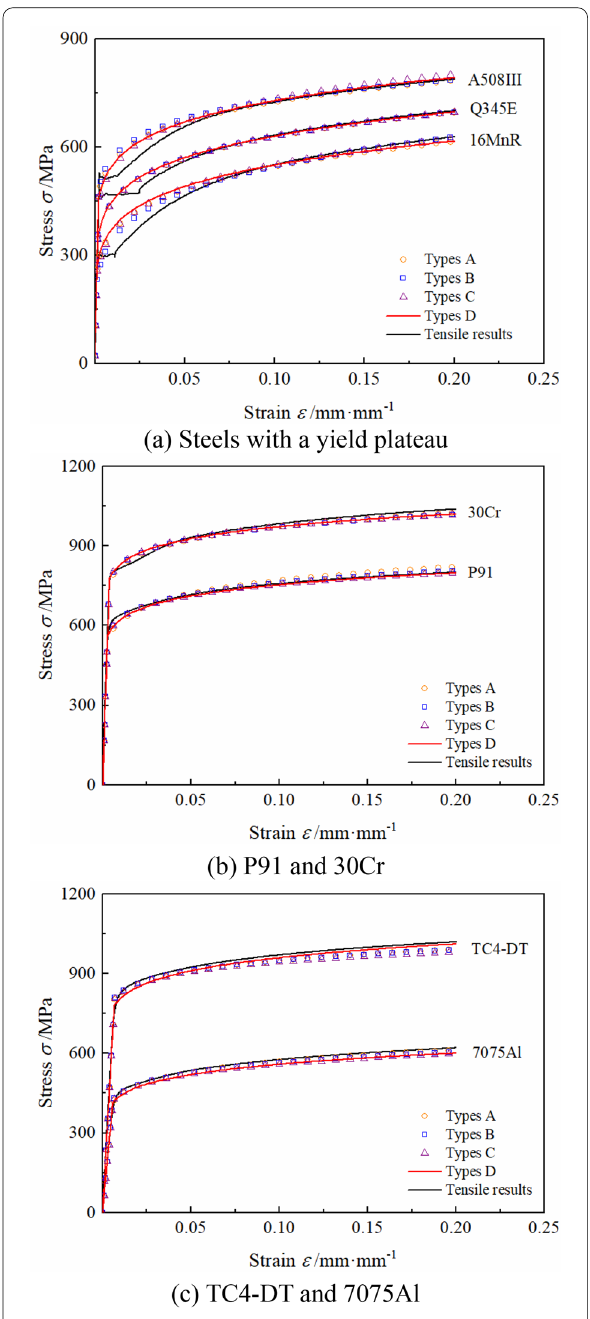
Figure 13 Comparison between the predicted σ– ε relations u and those obtained by traditional tensile tests